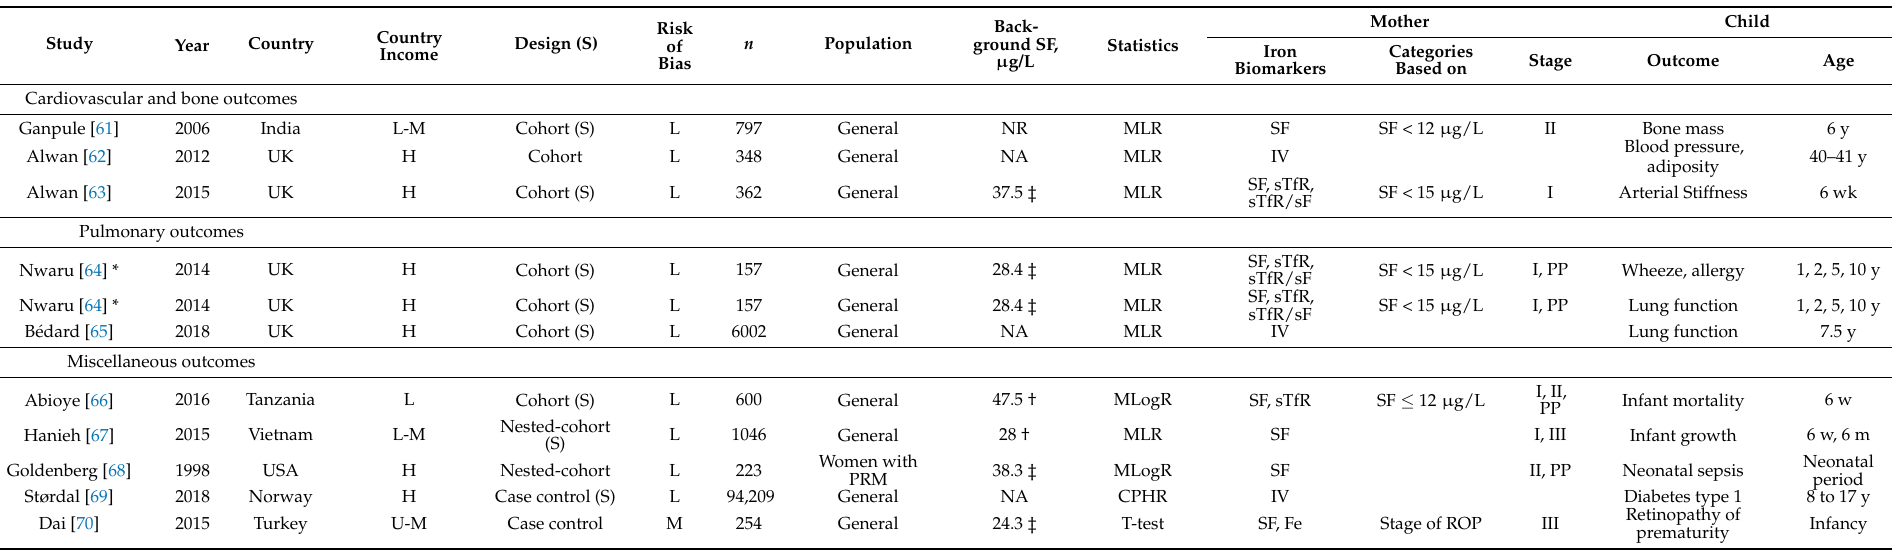
Country income according to World Bank classification (https://datahelpdesk.worldbank.org/knowledgebase/articles/906519 accessed on 20 July 2020 ); corr, correlation; CPHR, Cox proportional hazard regression; d, days; I, II, III, gestational trimester; H, high; IV, instrumental variable; L, low; L-M, lower-middle; U-M, upper-middle; MWU, Mann–Whitney U-test; M, medium; m, months; MLR, multiple linear regression; MLogR, multiple logistic regression; NA, not applicable; PP, peri-partum; PRM, premature rupture of the membranes; ROP, retinopathy of prematurity; SF, ferritin represents reported (or calculated); sTfR, soluble transferrin receptor; (S), maternal iron supplementation; TF, transferrin; TSAT, transferrin saturation; TIBC, total iron binding capacity; wk, week; y, year. * Studies reporting multiple outcomes; †, median; ‡, mean; values in the total study